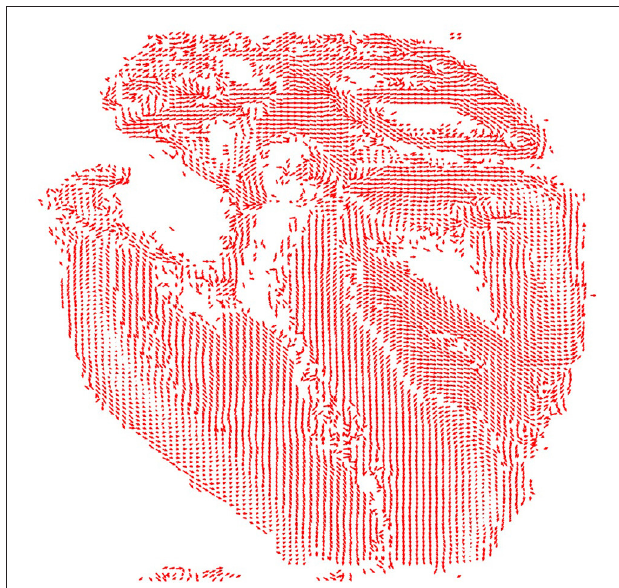
FIGURE 1 | The 143 DGA human fetal heart [45]. BeatBox [44] geometry .bbg format visualization with projections of the unit vectors of the local fiber orientation onto the cross-section plane: a smooth intramural fiber distribution has developed, with some surface irregular fibers from earlier developmental stages, as seen in Figure 4 [45, p.